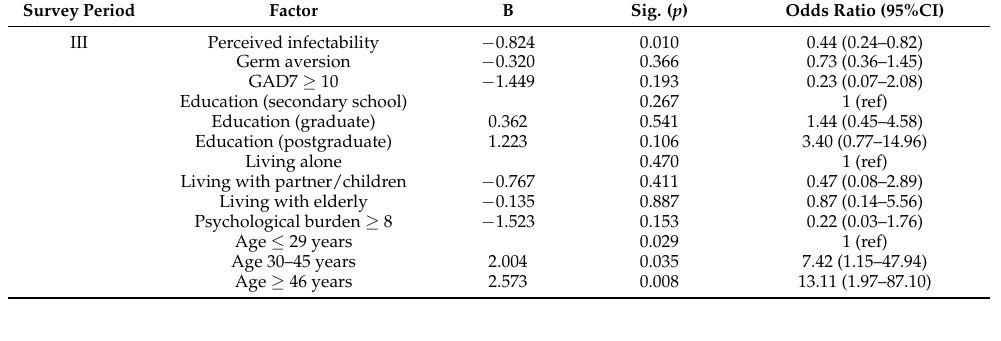
Table 6. Regression analysis of factors influencing decision for vaccination in third survey period.